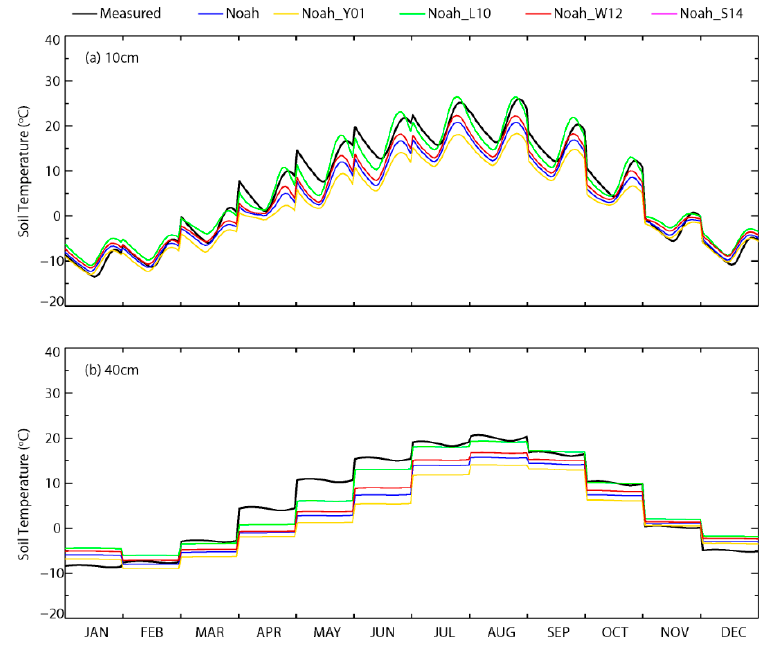
Figure 4. Simulated and observed monthly mean diurnal cycles of soil temperature at ( a ) 10 and ( b ) 40 cm. Table 4. Coefficients of correlation (R), model efficiency index (NSE), mean bias error (MBE), and root mean square error (RMSE) between observation and simulation of soil temperatures at five different depths.